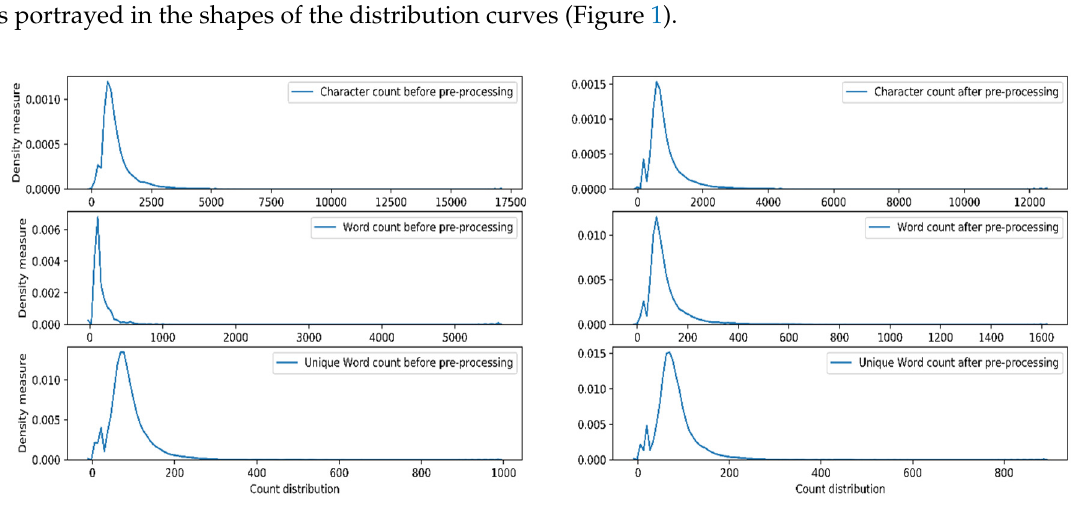
Figure 3. Words percentage change after pre-processing. 3.2. Classification We randomly sampled 11,000 reports (from the total of 60,068 that survived pre-processing), where the SNOMED-CT codes indicated the “Malignant”, “Non-malignant”, and “No diagnosis”